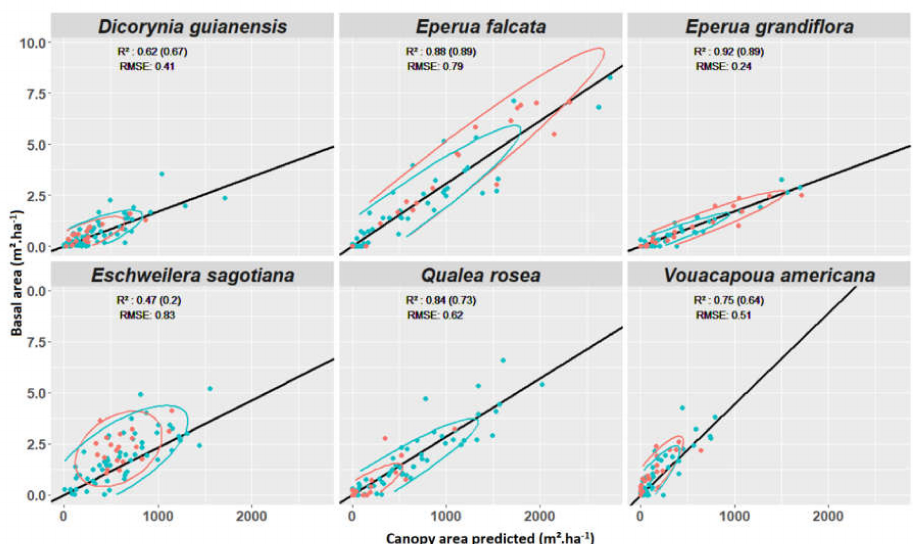
Figure 7. Relation between basal areal (m 2 · ha − 1 ) and area predicted (m 2 · ha − 1 ) using the optimized LDA. Plots not used for training are plotted in red and the R-squared for those observations given in brackets. The plot used for the training are in blue. Global R-squared values are given using all points (red and blue). In solid black line, linear regression based on all points passing through zero. The normal confidence ellipses are given, computed for each group points using the corresponding color (red or